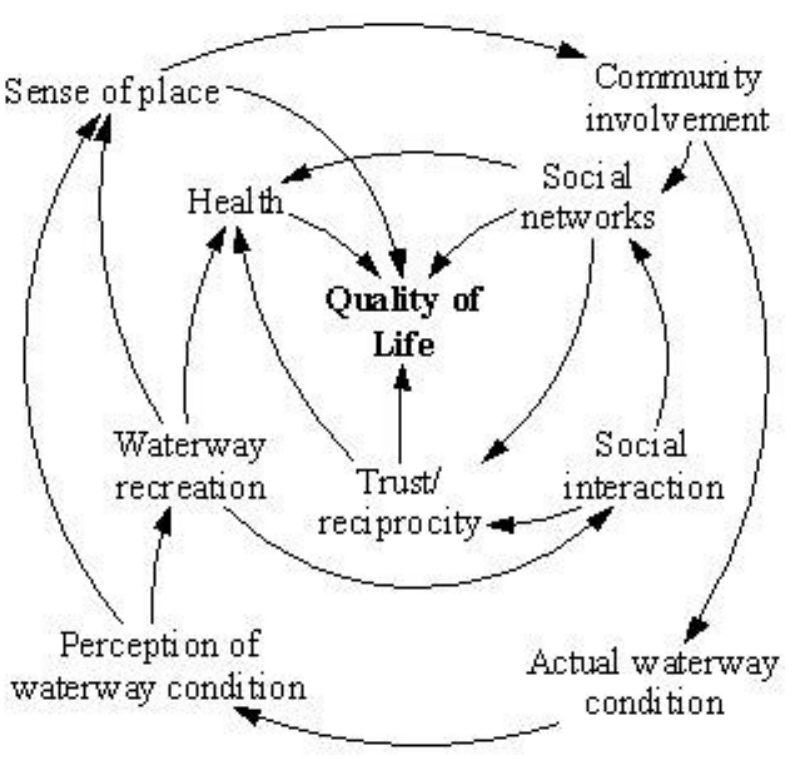
Fig. 1. Hypothesized relationships between waterway condition and quality of